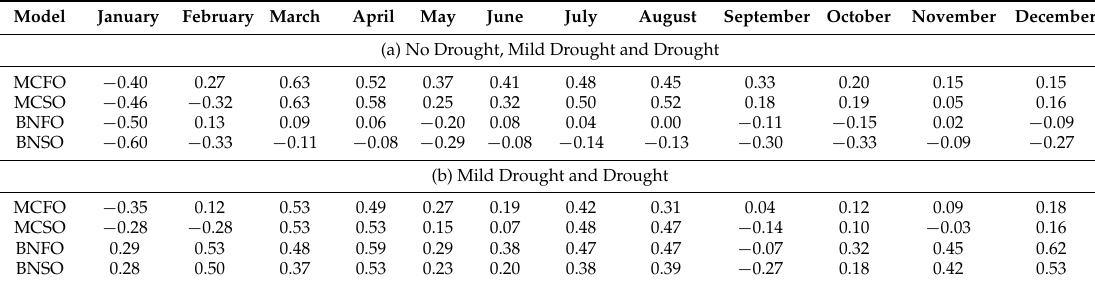
Table 7. RPSS values of the monthly assessment of drought